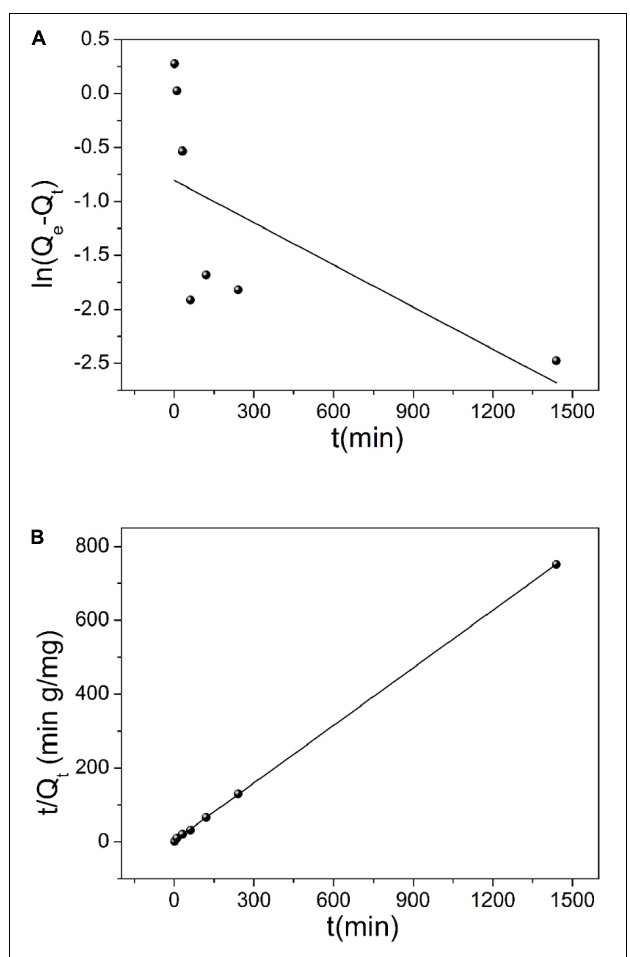
FIGURE 6 | The fitting of pseudo–first-order (A) and pseudo–second-order (B) kinetic models for uranium (VI) adsorption on TiO 2 /Ti.